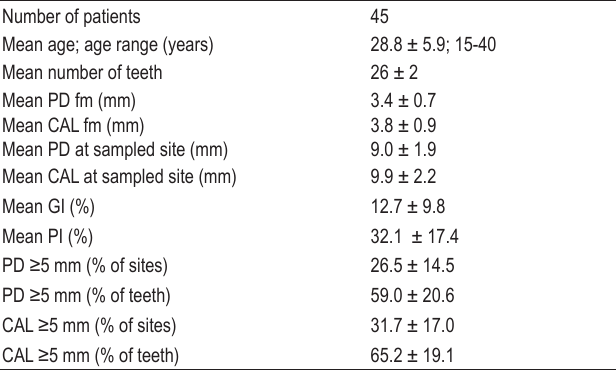
Table 1 - Clinical data of the GAgP patients.